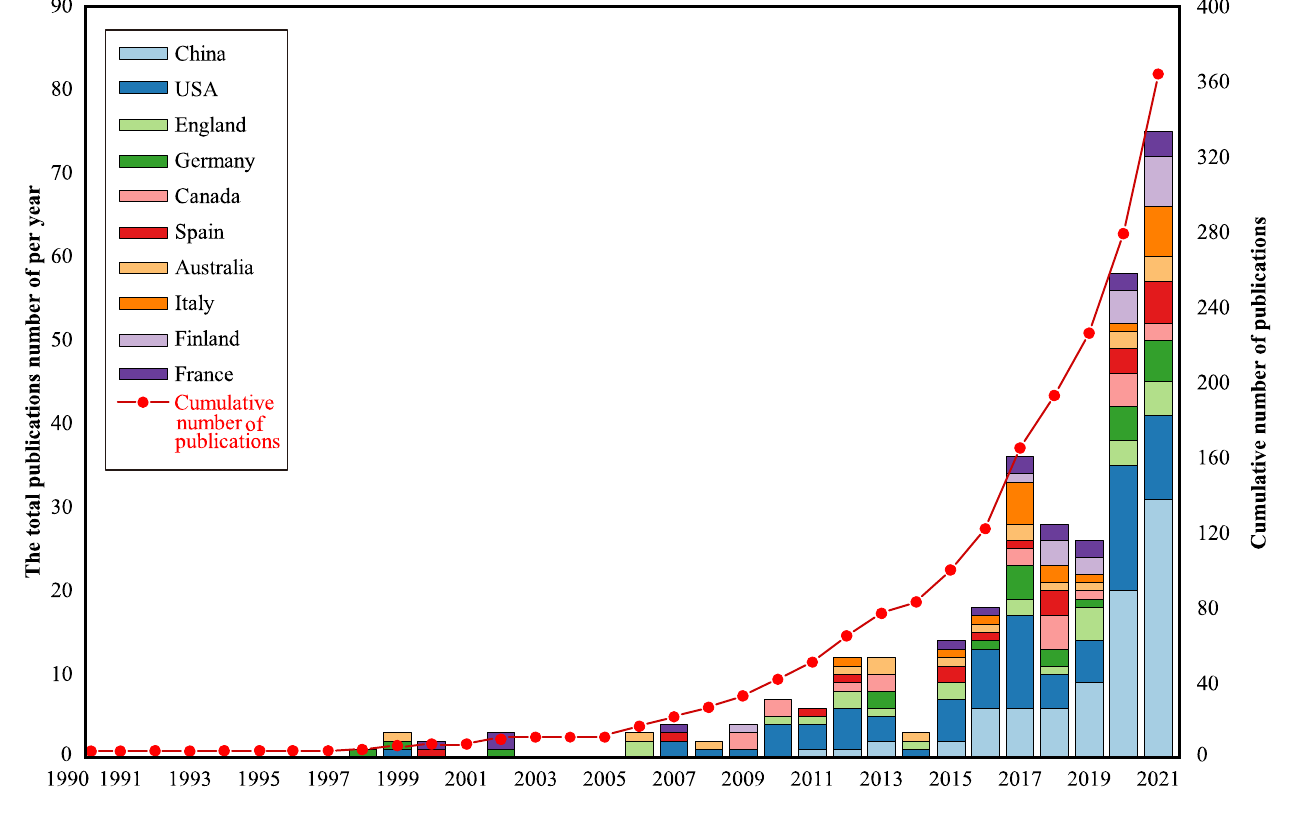
Figure 1. Annual change curves for articles published in the field of CPCN in buildings (1990–2021).